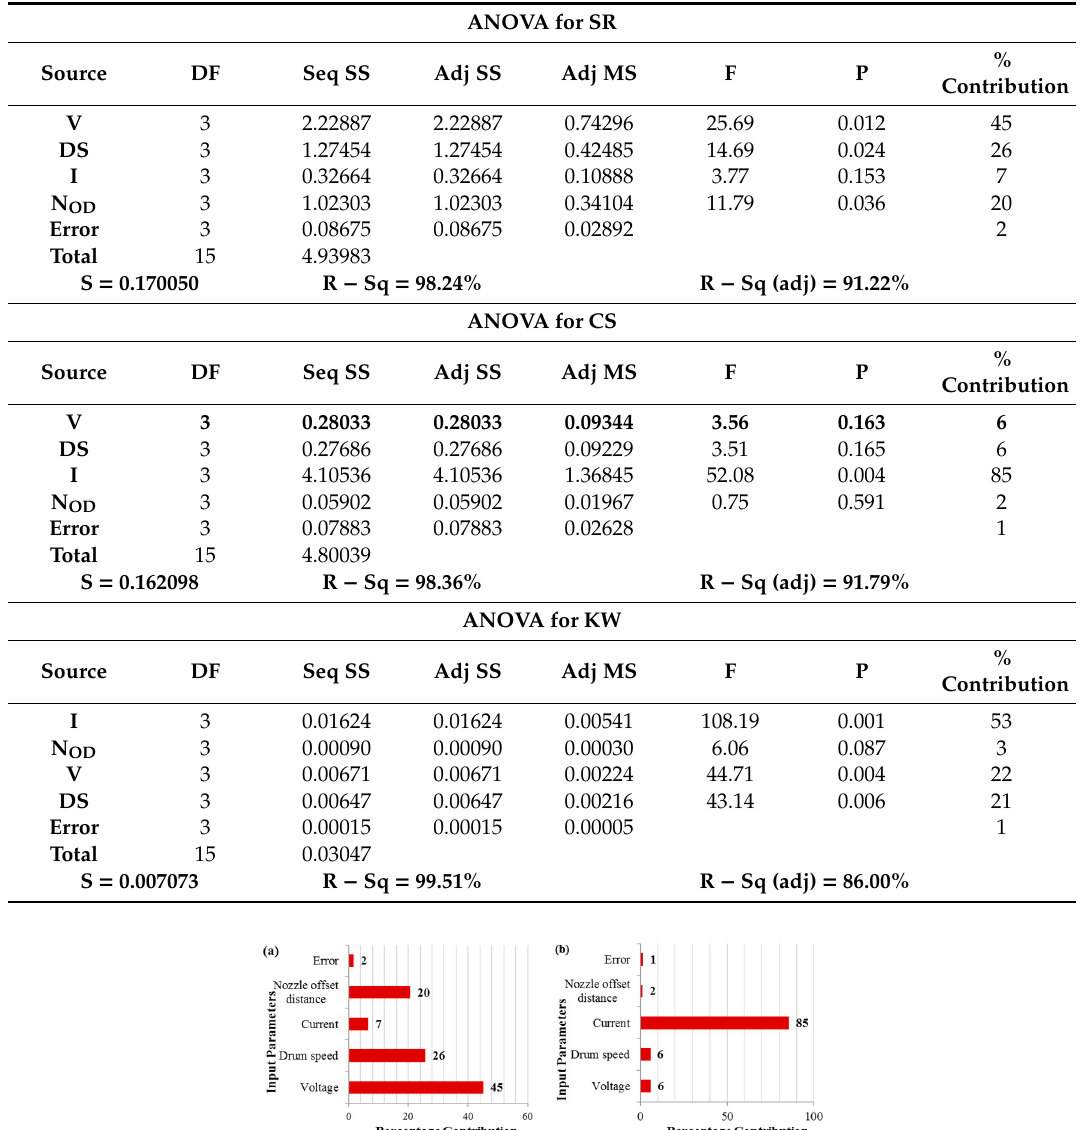
Table 3. ANOVA for surface roughness (SR), cutting speed (CS), and kerf width (KW).